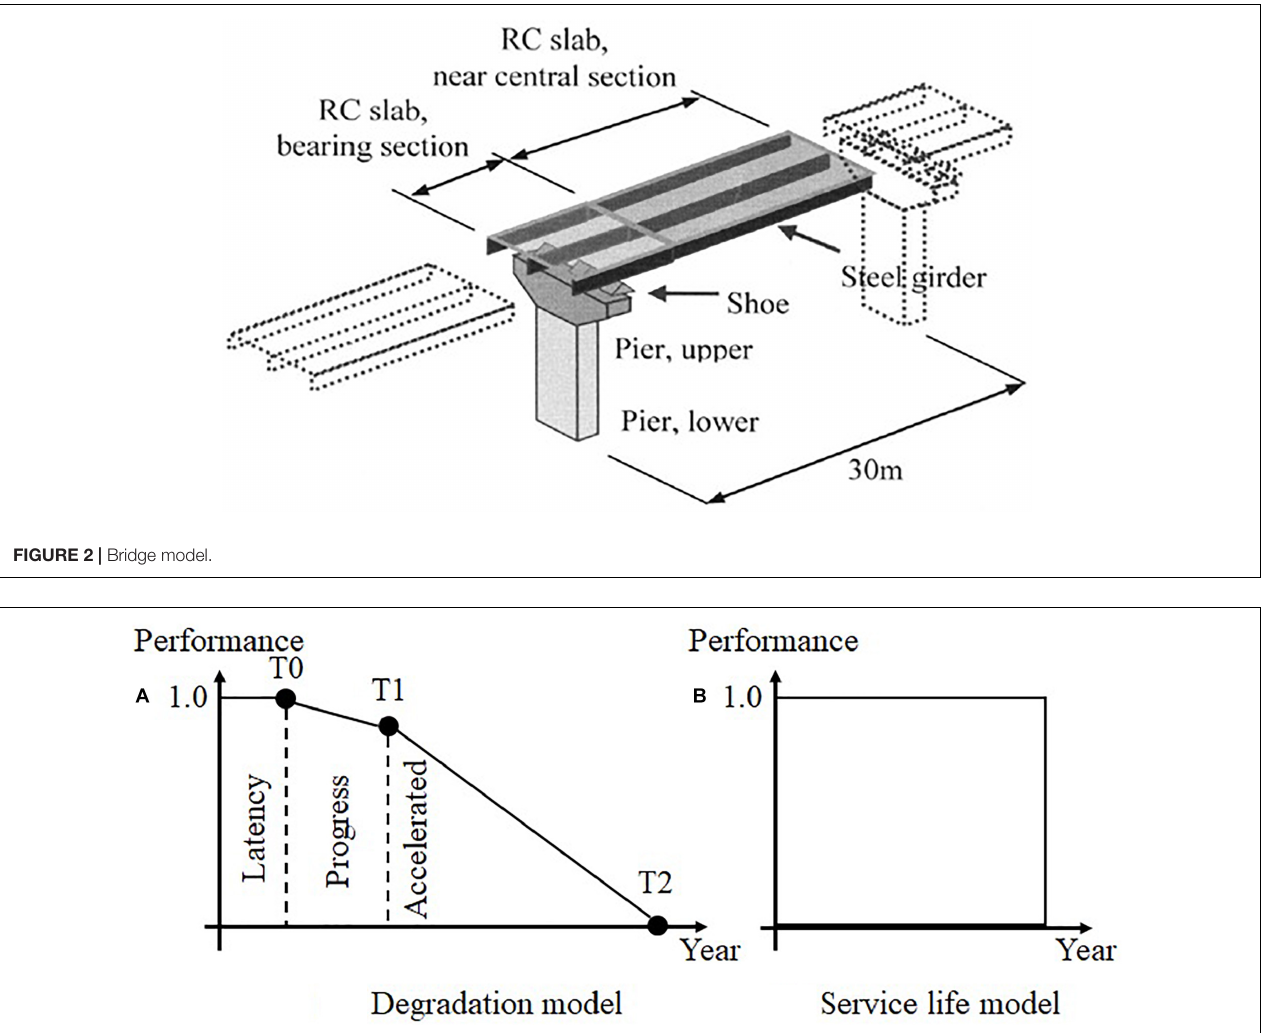
FIGURE 3 | Deterioration model of bridge. (A) Degradation model, and (B) Service life